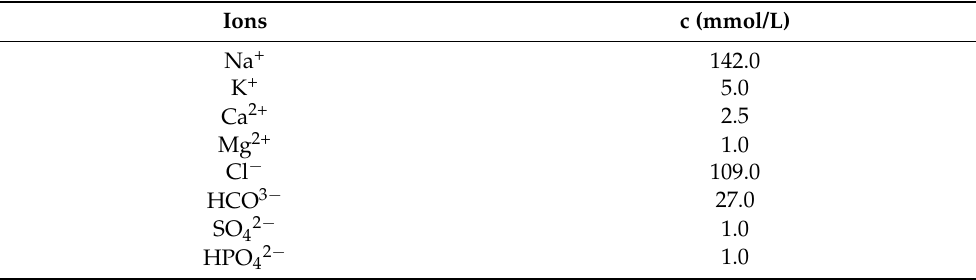
Table 1. Composition of SBF27 solution, data from Müller, L. et al. [46].